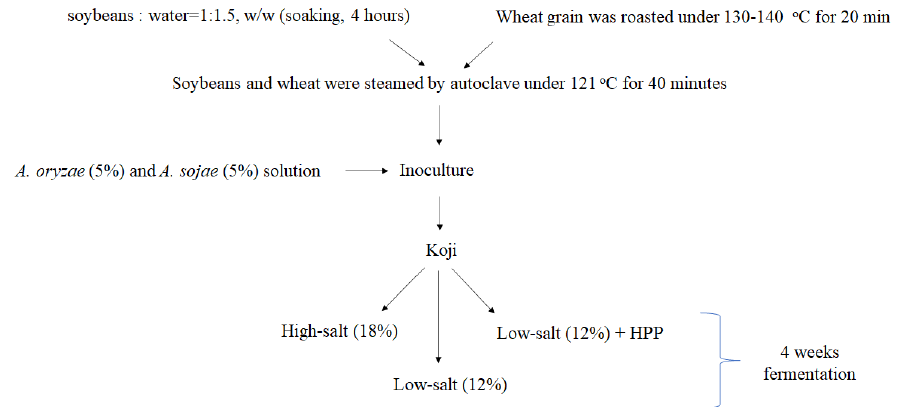
Figure 1. The schematic representation of soy sauce.